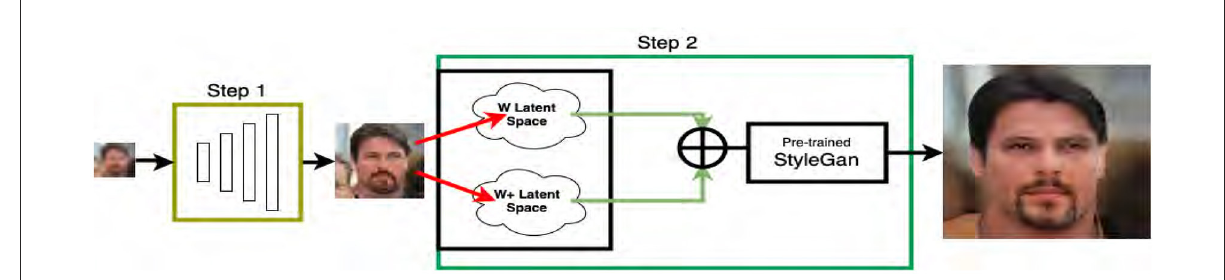
Figure 4. The trained Low to High generator is used to get the MR image. Red arrows indicate the projection to the generative model latent space. Green arrows represent the interpolation in the latent space as defined in Equation (6). The interpolated latent vectors are combined using Equation